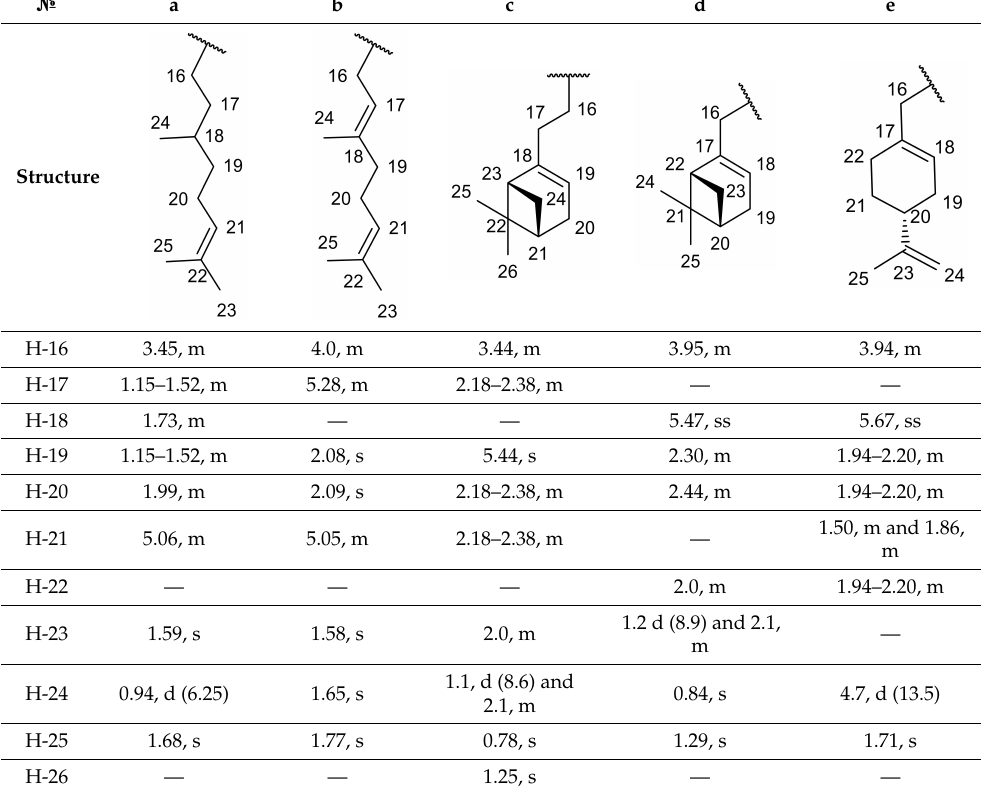
Table 1. NMR 1 H spectra of 11a – e . № a b